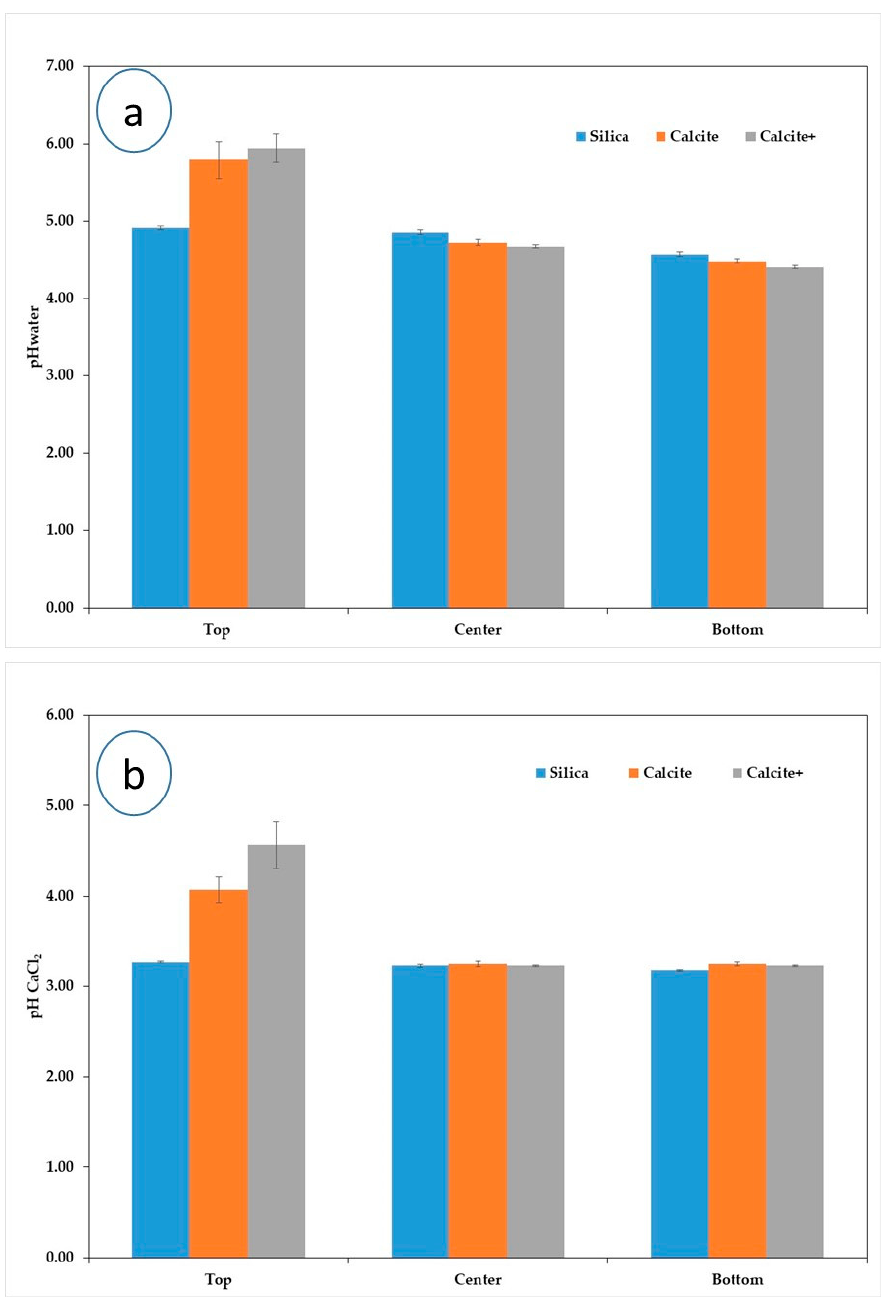
Figure 6. Variation of the gradient of ( a ) pH water and ( b ) pHCaCl 2 of peat substrate during the first growing season (2 June 2014, before fertilization) of white spruce seedlings according to the covering material (silica: 29 g/cavity, calcite: 24 g/cavity and calcite+: 31 g/cavity) and the level of the substrate plug (top, center and bottom).